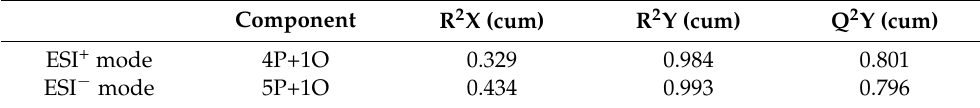
Table 2. The parameters of the OPLS-DA model.